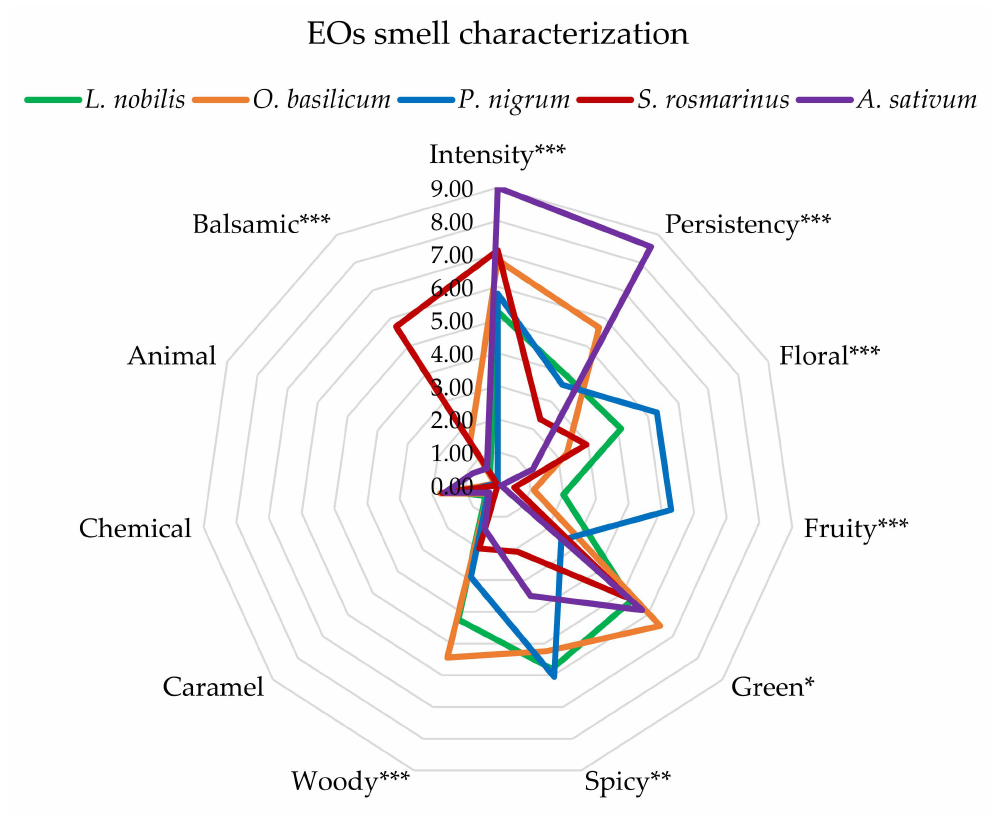
Figure 4. All the smell descriptors attributed by the trained panel to the Allium sativum , Laurus nobilis , Ocimum basilicum , Piper nigrum, and Salvia rosmarinus essential oil (EO) on a 0–9 scale. Significance level. *** = p < 0.001; ** = p < 0.01; * = p < 0.05; = not significant ( p >